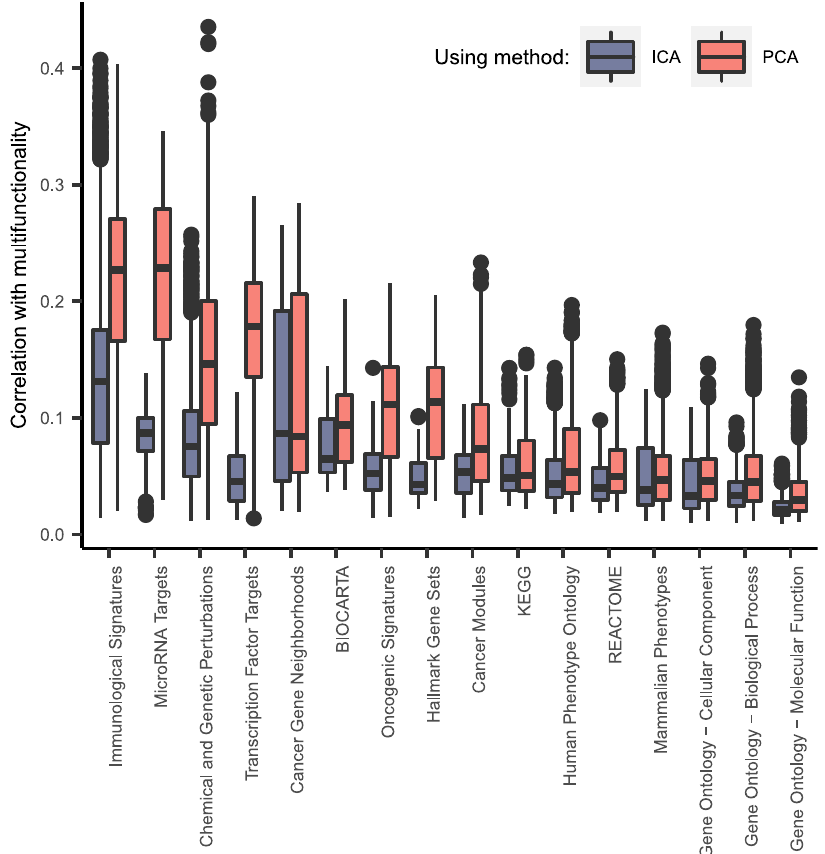
Fig. 4 Correlation between prediction scores and gene multifunctionality. Boxplot of distance correlation between gene set prediction scores of genes ( n = 19,635) and the gene set collection multifunctionality score ( y -axis) for each gene set collection ( x -axis). Multifunctionality scores are compared against ICA-TC-based (blue) or PCA-TC-based (red) predictions. The magnitude of correlation varies across gene set collections and between gene sets in a collection. The associations between the degree of multifunctionality and the prediction scores were lower for the ICA-TC-based method than the PCA- TC-based method (area under the curves (AUCs) calculated from two-sided Mann – Whitney U test range 0.03 – 0.47). Hinges of boxes represent second and third quartiles and whiskers extend by half that interquartile range. Center of box corresponds to